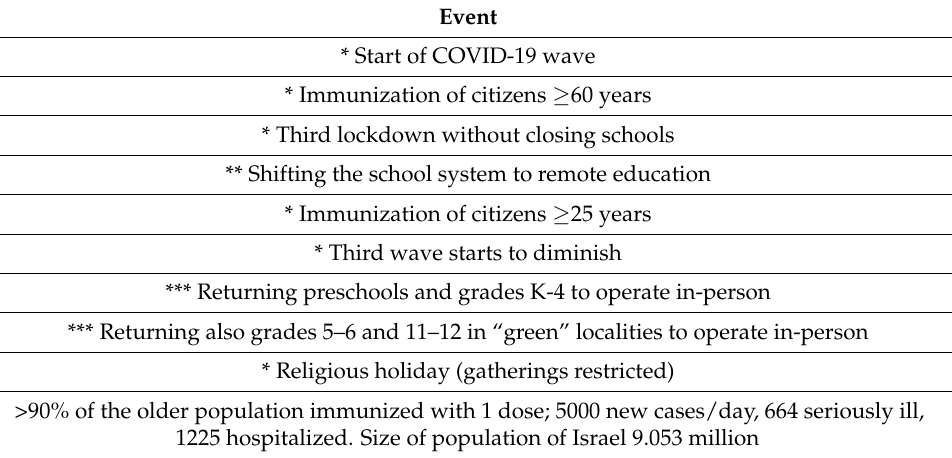
Table 1. Important regulatory events in handling COVID-19 pandemic in Israel close to the start of the